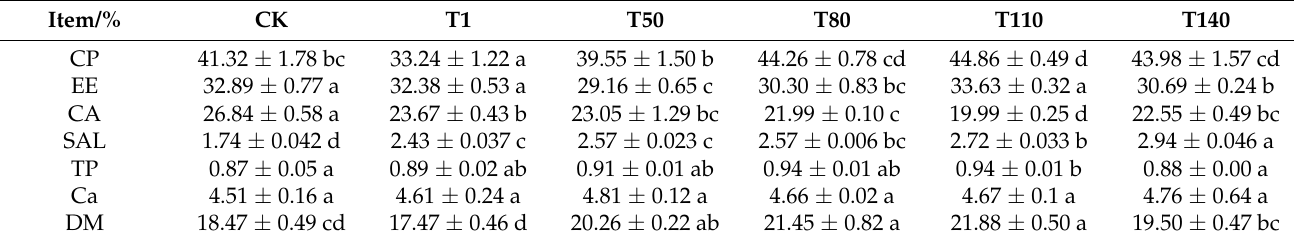
Table 4. Effect of adding DKW on the body components of the BSFL.